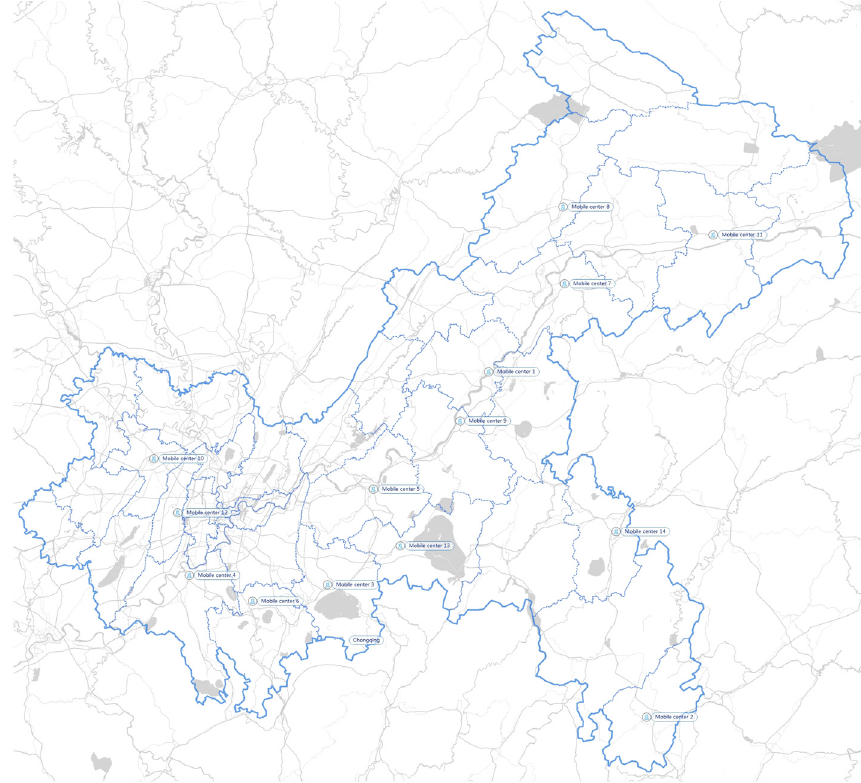
Figure 6. MPCs in Chongqing.